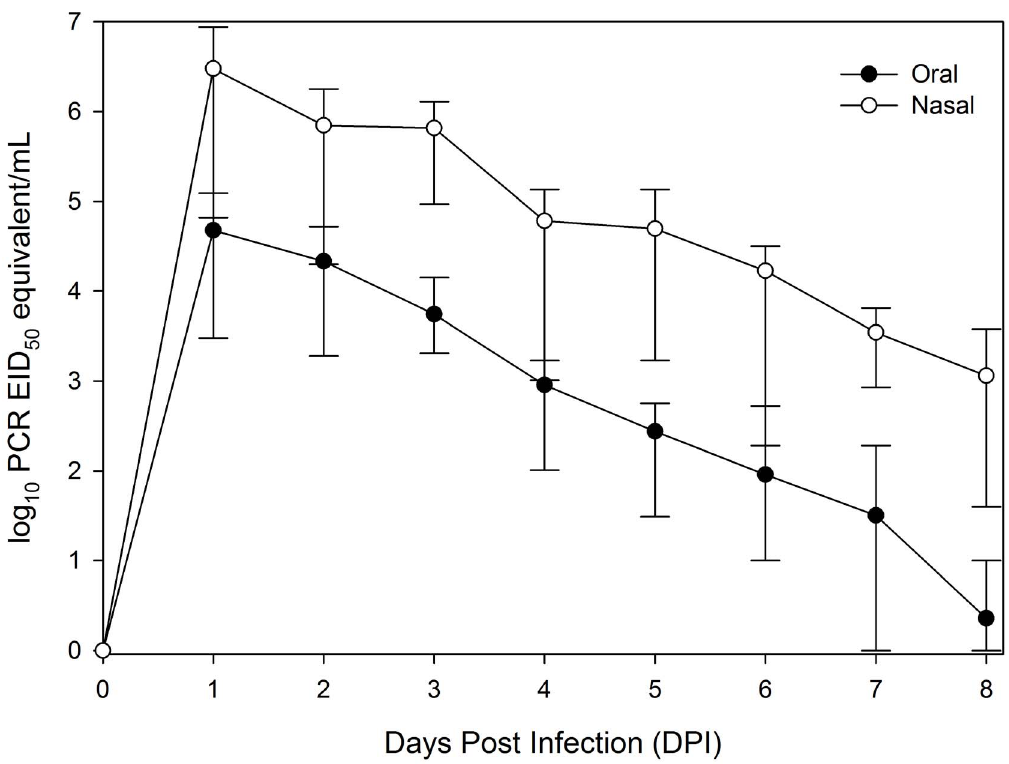
Figure 1. Mean nasal and oral shedding of avian influenza virus RNA of desert cottontails experimentally infected with a low- pathogenic avian influenza virus. Shedding was assessed from nasal washes and oral swabs by RRT-PCR. Results are presented as log 10 PCR EID 50 equivalents/mL. Vertical bars represent the maximum and minimum quantities detected on a given day.